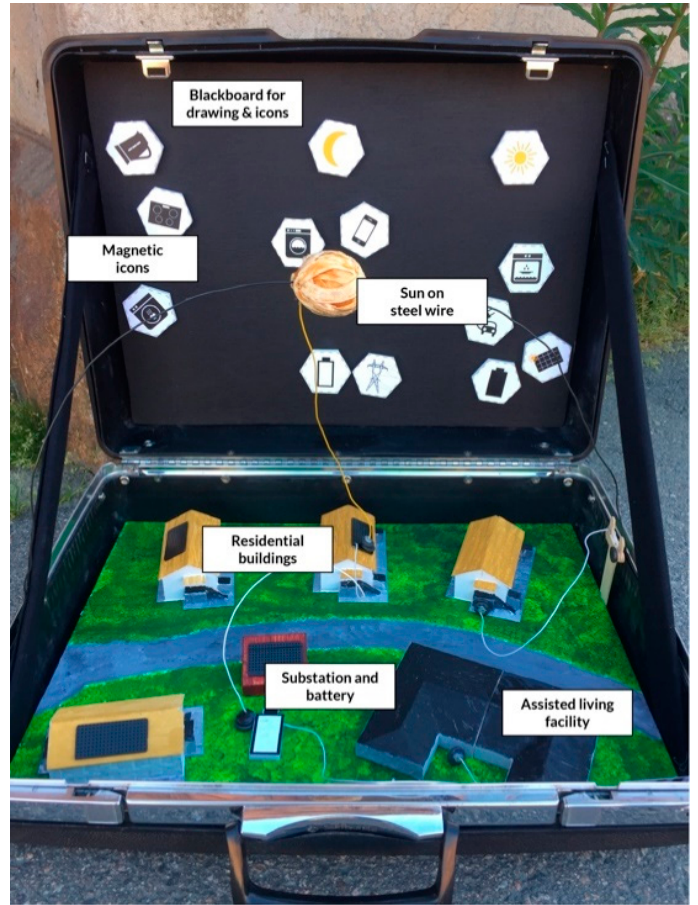
Figure 1. The microgrid toolbox.